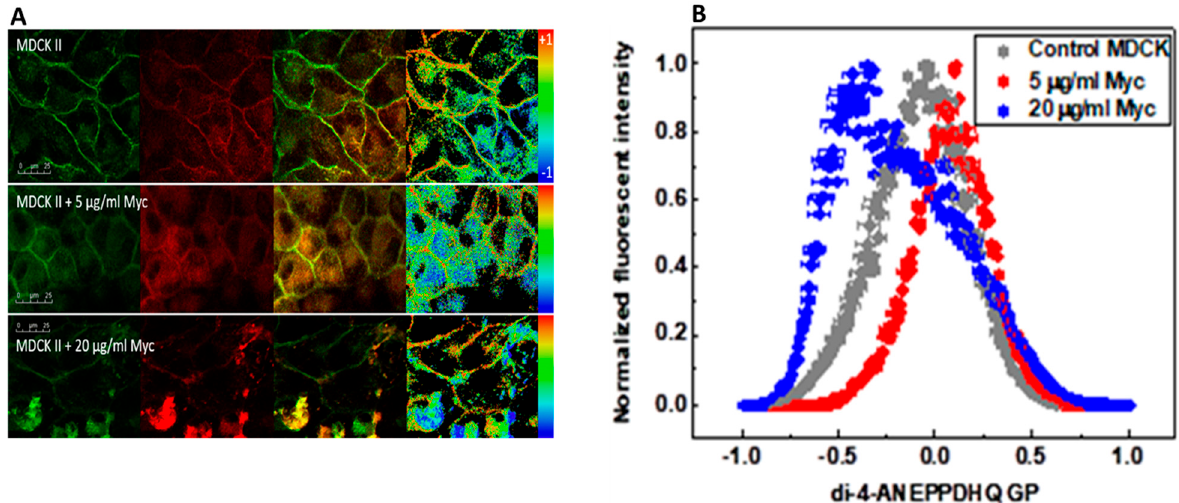
Figure 4. Visualization of MDCKII cell membrane lipid packing by confocal fluorescence microscopy. ( A ) Fluorescence GP images of untreated and myconoside-treated MDCKII cells stained with di-4-ANEPPDHQ. Two channels (first and second columns) have green and red colors, respectively. Merged channels are exhibited in the third column. GP of the cells indicating the range of the calculated GP values (fourth column). The GP values vary from − 1 (blue color, low lipid order) to +1 (red color, high lipid order). ( B ) Histogram of the GP values acquired from GP images of untreated and myconoside-treated MDCKII cells stained with di-4-ANEPPDHQ. The gray curve corresponds to untreated cells, and the red and blue ones to myconoside-treated cells with 5 µ g/mL and 20 µ g/mL, respectively.